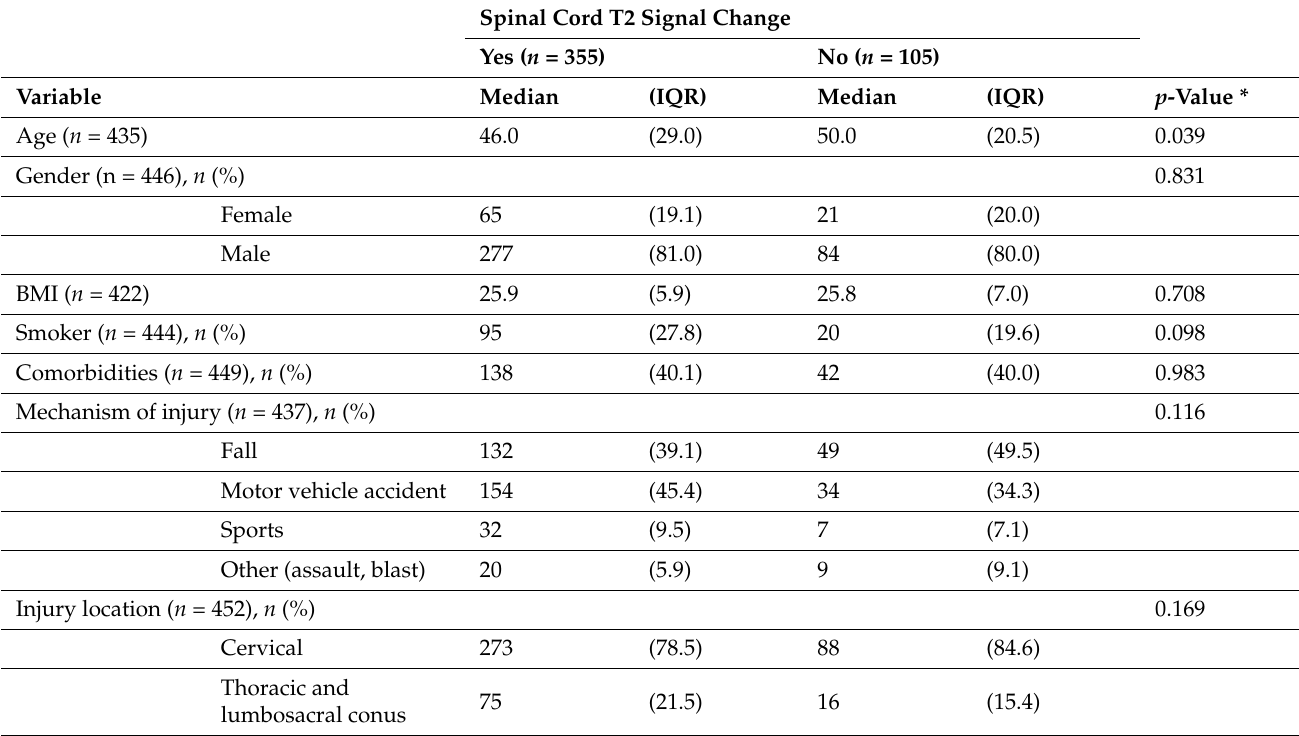
Table 2. Baseline data for spinal cord injury patients stratified by radiographic spinal cord signal change ( n = 459). Spinal Cord T2 Signal